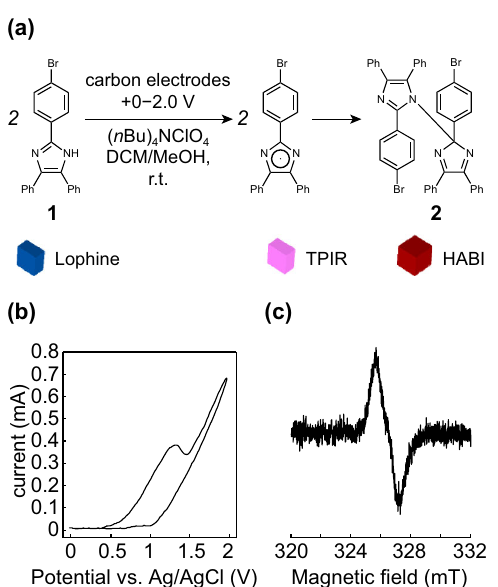
Fig. 2 Electrochemical oxidation of 1. a Synthesis of 2 upon applying potential to DCM/MeOH solution of 1 containing ( n Bu) 4 NClO 4 with carbon electrodes. b Cyclic voltammogram of 1 using ( n Bu) 4 NClO 4 as a support electrolyte. c ESR spectrum of 2 upon